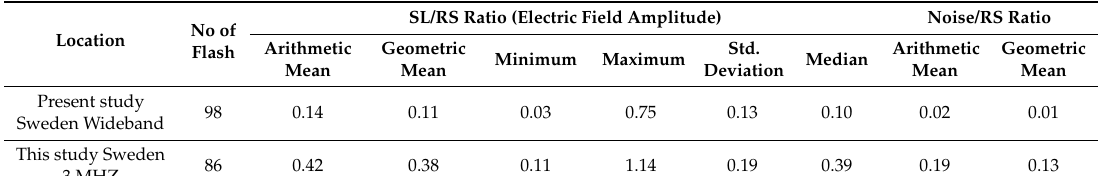
Table 4. Stepped leader (SL) to RS electric field amplitude ratio.